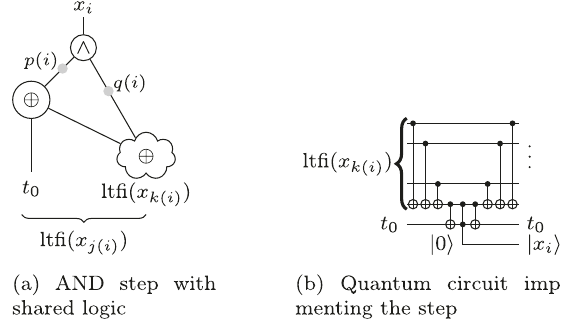
Fig. 5 A special con fi guration with one transitive fan-in included in the other. a A special AND step in an XAG network; b corresponding compiled quantum circuit.